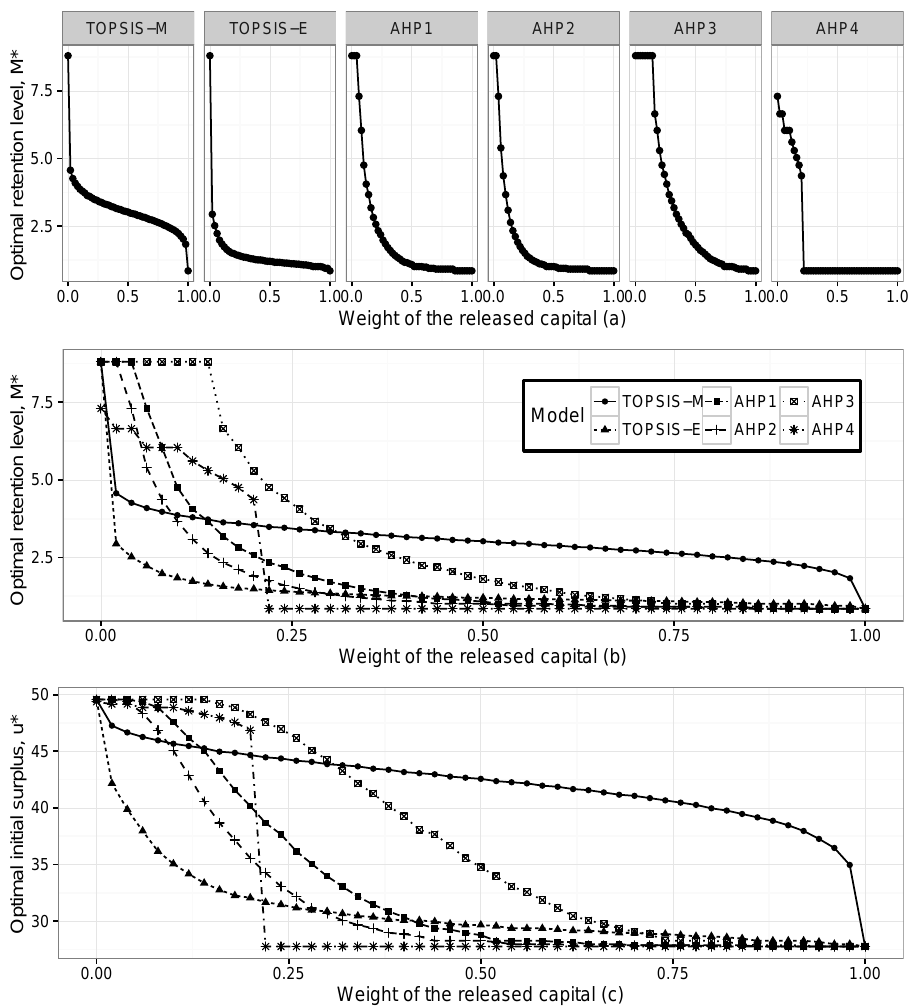
Figure 2. The graph of the optimal initial surplus and optimal retention level when θ = 0.1 and ξ = 0.15 for the exponential